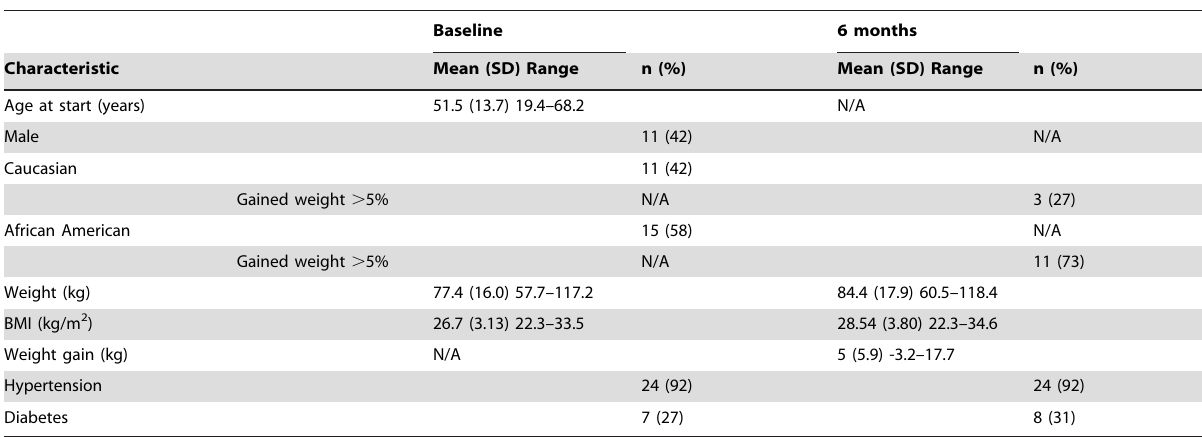
Table 1. Subject characteristics (N =26).